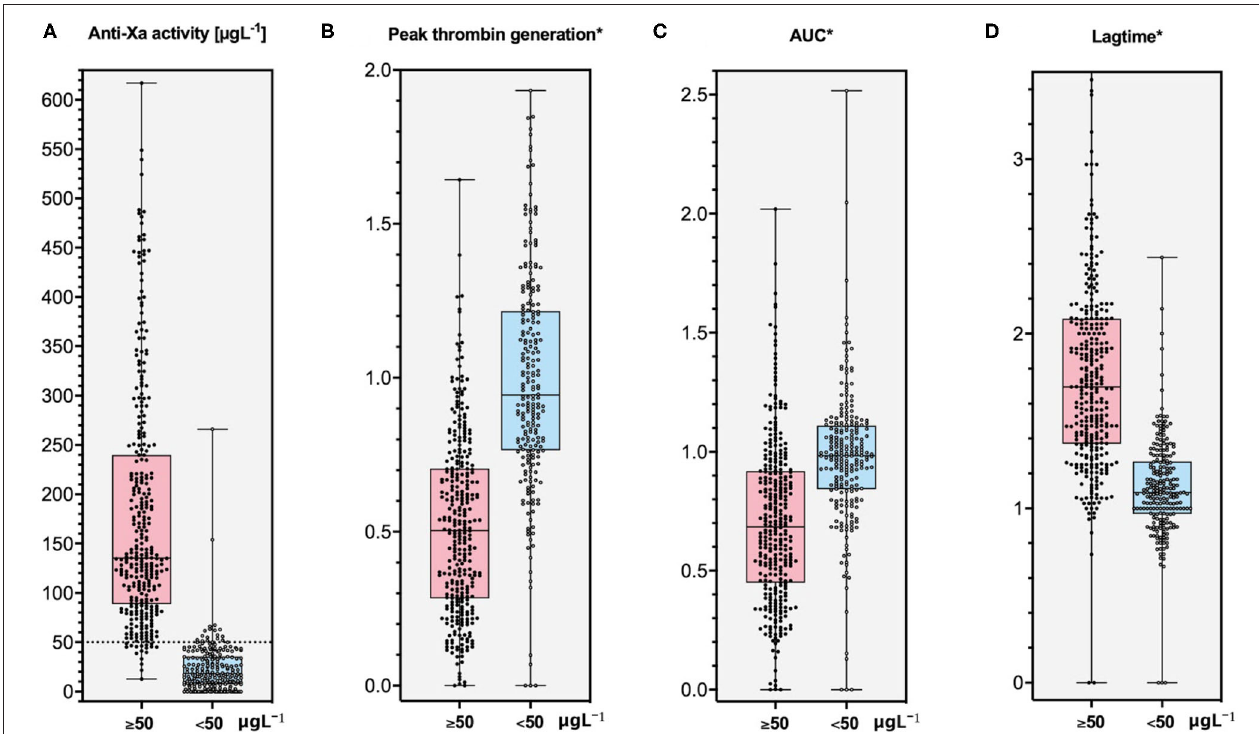
FIGURE 3 | Distribution of thrombin generation results and anti-Xa measurements in patients with and without clinically relevant concentrations of rivaroxaban, apixaban, and edoxaban (50 µ g L − 1 ): (A) anti-Xa activity, (B) peak thrombin generation, (C) area under the curve (AUC), and (D) lag time. * Thrombin generation results are expressed in relation to measurements obtained with standardized human plasma (for example: AUC patients/AUC SHP). Ultra-high performance liquid chromatography-tandem mass spectrometry (LC-MS/MS) was used to determine drug levels. The sensitivity was 83% (95% CI, 78, 87) in case of peak thrombin generation (cut-off level was 80% of normal plasma), 61% (56, 66) in case of AUC (80% of normal plasma), 89% (85, 92) in case of lag time (120% of normal plasma), and 95% in case of anti-Xa activity (95% CI, 92, 97). The specificity was 70% (95% CI, 64, 76) in case of peak thrombin generation, 78% (72, 83) in case of AUC, 66% (60, 72) in case of lag time, and 92% in case of anti-Xa activity (95% CI, 88,